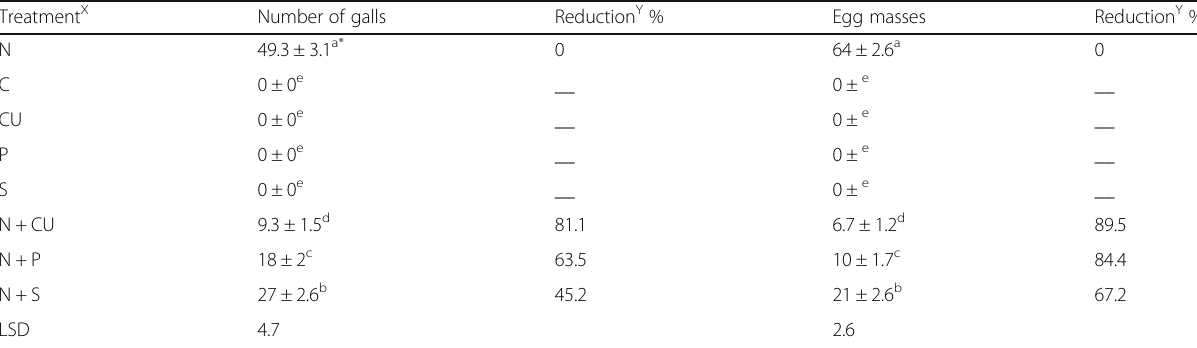
Fig. 12 Dissolved oxygen, agitation, and aeration as a function of time during batch fermentation no. 2 of Bacillus subtilis isolate B10 incognita [at a concentration of 5% (1:20)] at 2 h re- corded 1% and reached its highest value of 61% at 8 h fermentation no. 2 that started in a bioreactor with op- tical density of 0.5 at 550 nm, biomass, percentage of ju- venile mortality of M. incognita and glucose concentration of B. subtilis isolate B10 plotted against time, the maximum biomass achieved was 4.52 g/l at Table 1 Effect of culture broth, cell pellet, and supernatant of Bacillus subtilis isolate B10 on number of galls and egg masses of Meloidogyne incognita occurrence in the roots of tomato plants Treatment X Number of